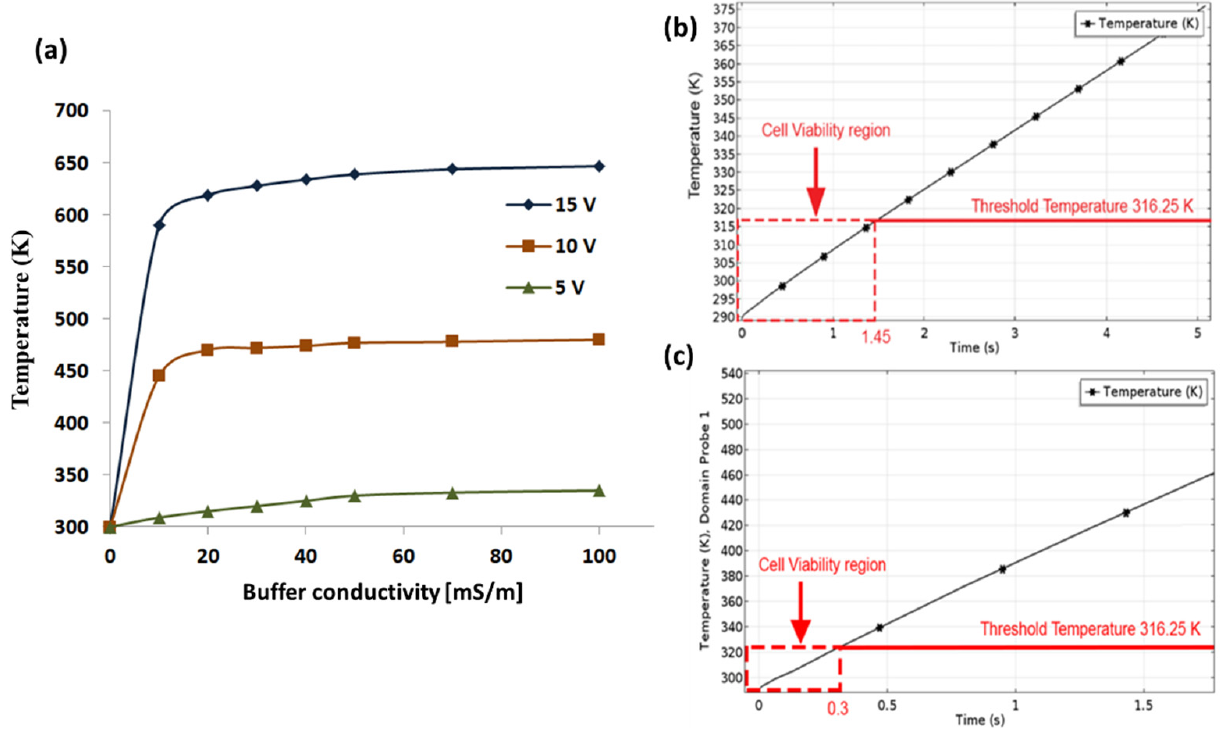
Figure 4. Simulation studies showing the effect of temperature at different conductivity level of the medium [10 mS/m to 100 mS/m]. ( a ) The plot of the temperature variation inside the channel reveals that, increases in conductivity causes increase in temperature at an applied potential of 5 V to 15 V. ( b ) While keeping buffer conductivity at 10 [mS/m] and applied potential of 10 V, the survival time of cells inside micro channel is found to be 1.45 s. This duration is sufficient enough to selectively deflect the cells to target outlets. ( c ) When the buffer conductivity is increased from 15 mS/m to 55 mS/m, the survival time is reduced to 0.3 s–0.1 s, this duration is very less for cells to survive inside the channel and will cause cell